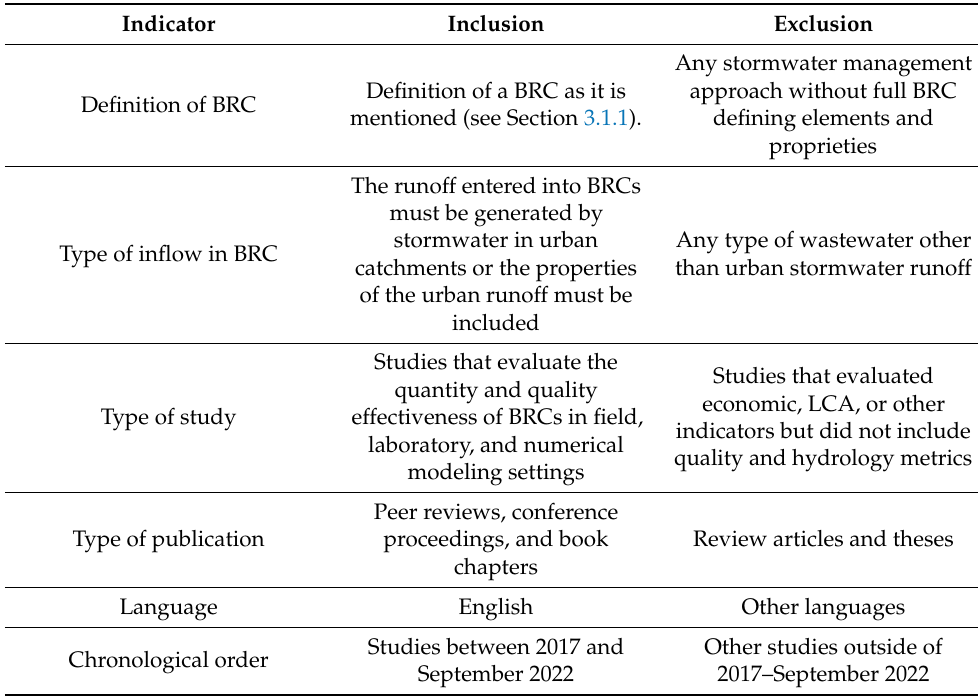
Table 1. Inclusion and exclusion indicators adopted to select relevant